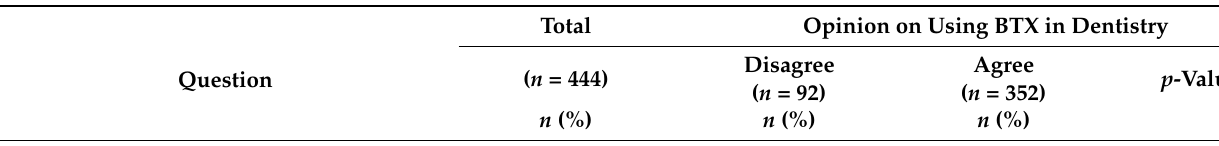
Table 2. Background knowledge concerning the application of botulinum toxin (BTX) in